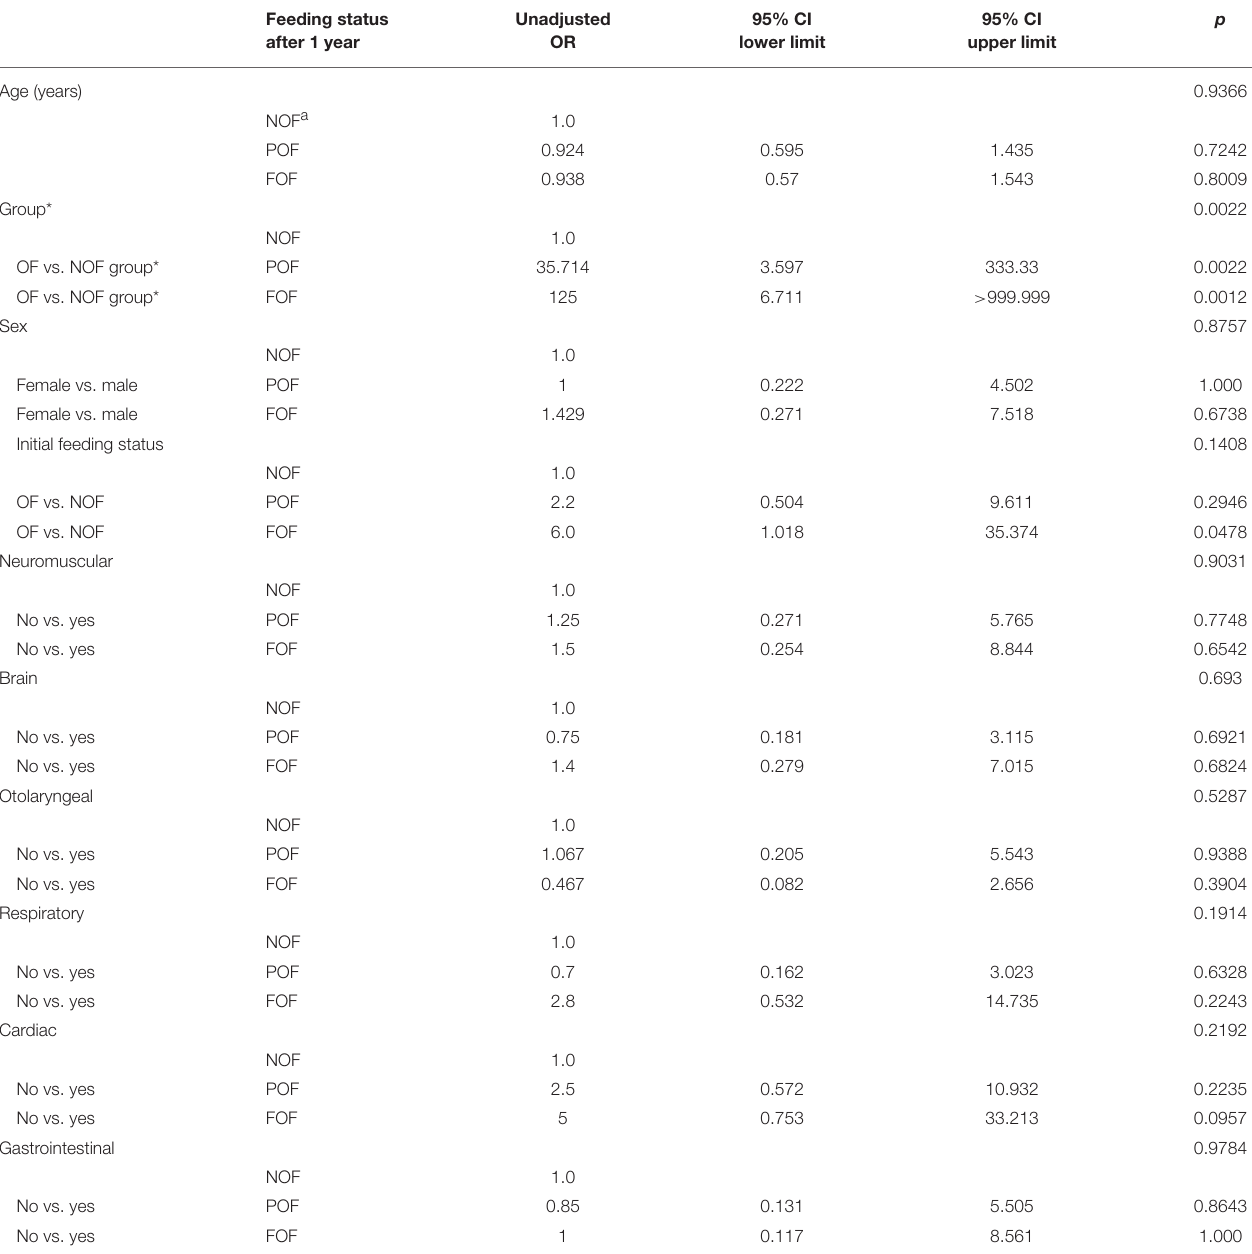
TABLE 3 | Univariate analysis via multinomial logistic regression for feeding status (full oral feeding, partial oral feeding, or non-oral feeding) 1 year after the initial VFSS. Feeding status after 1